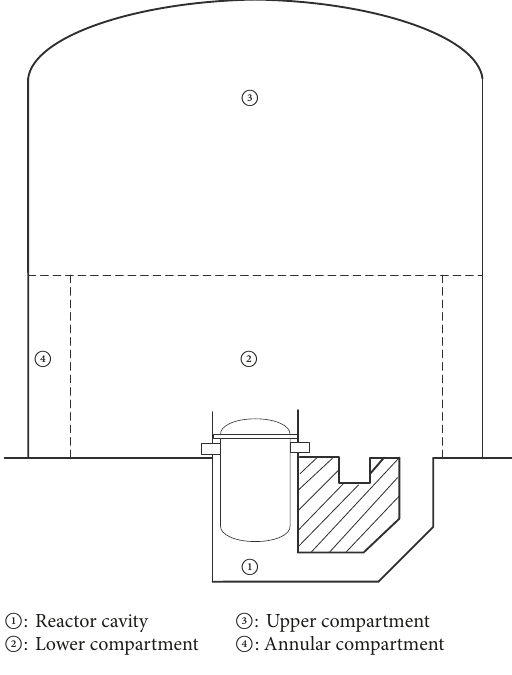
Figure 4: Containment structure.